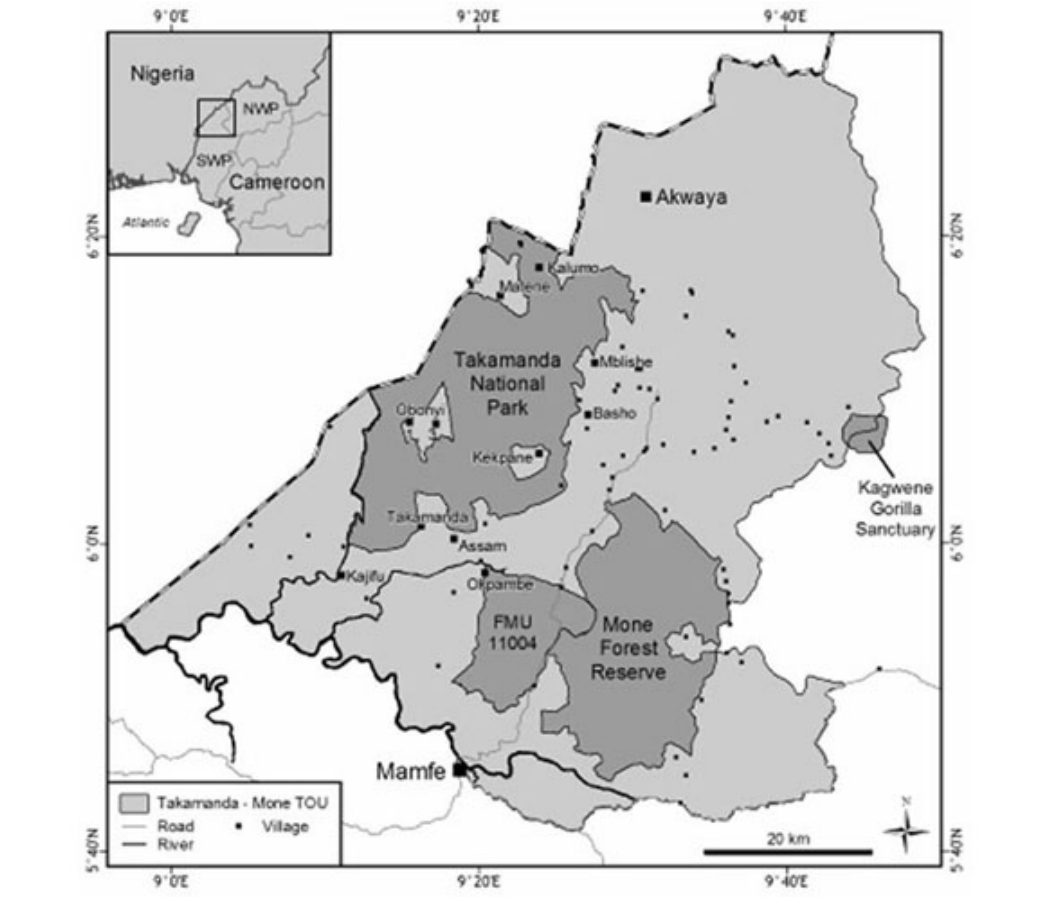
Fig. 1. Map of the Takamanda-Mone Technical Operations Unit and Takamanda National